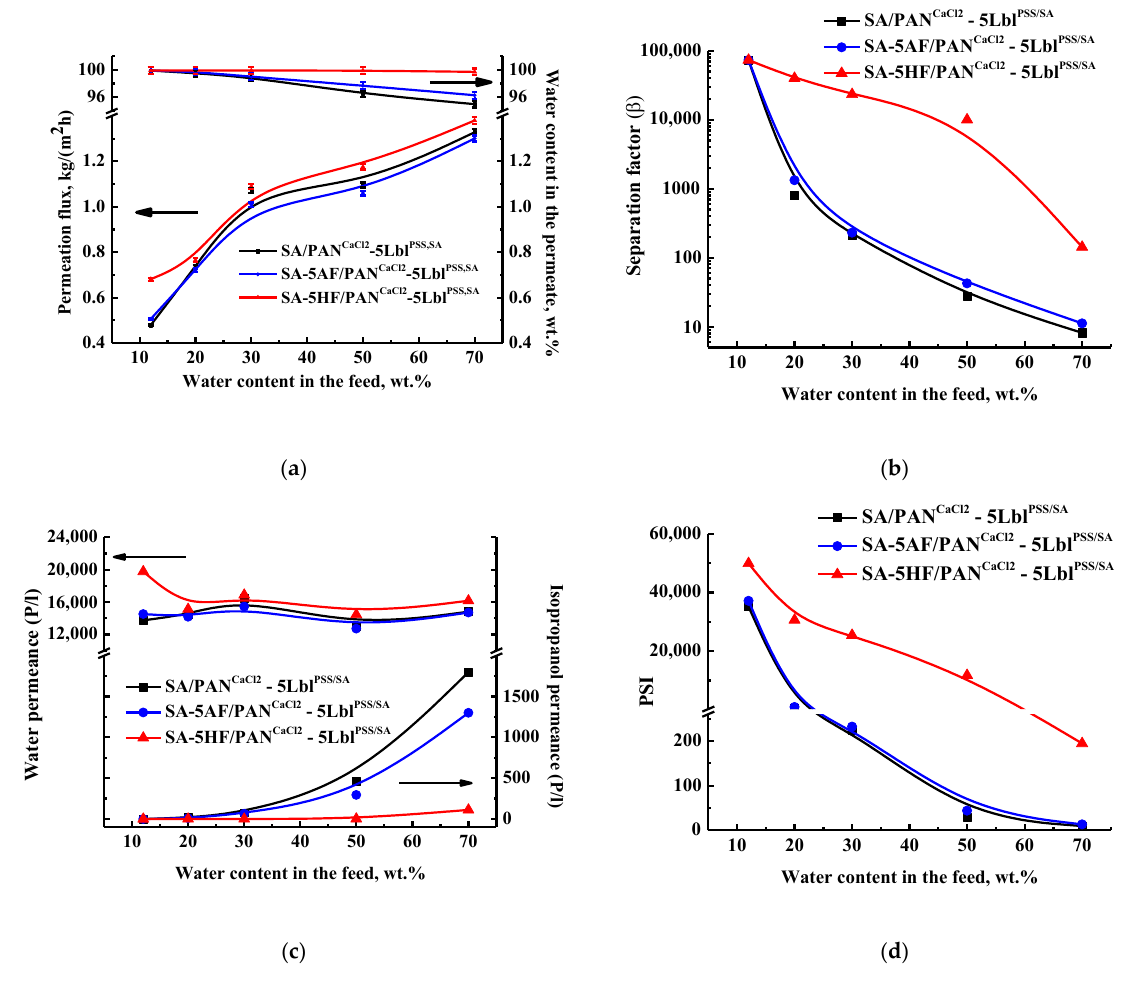
Figure 6. The dependence of ( a ) the water content in the permeate and the permeation flux, ( b ) the separation factor, ( c ) the component permeances, and ( d ) the PSI on the water content in the feed for the cross-linked PAN-supported membranes based on SA, SA-AF (5%), and SA-HF (5%) composites with five PSS/SA bilayers in the pervaporation dehydration of isopropanol (12–70 wt.% water) at 22 °C.